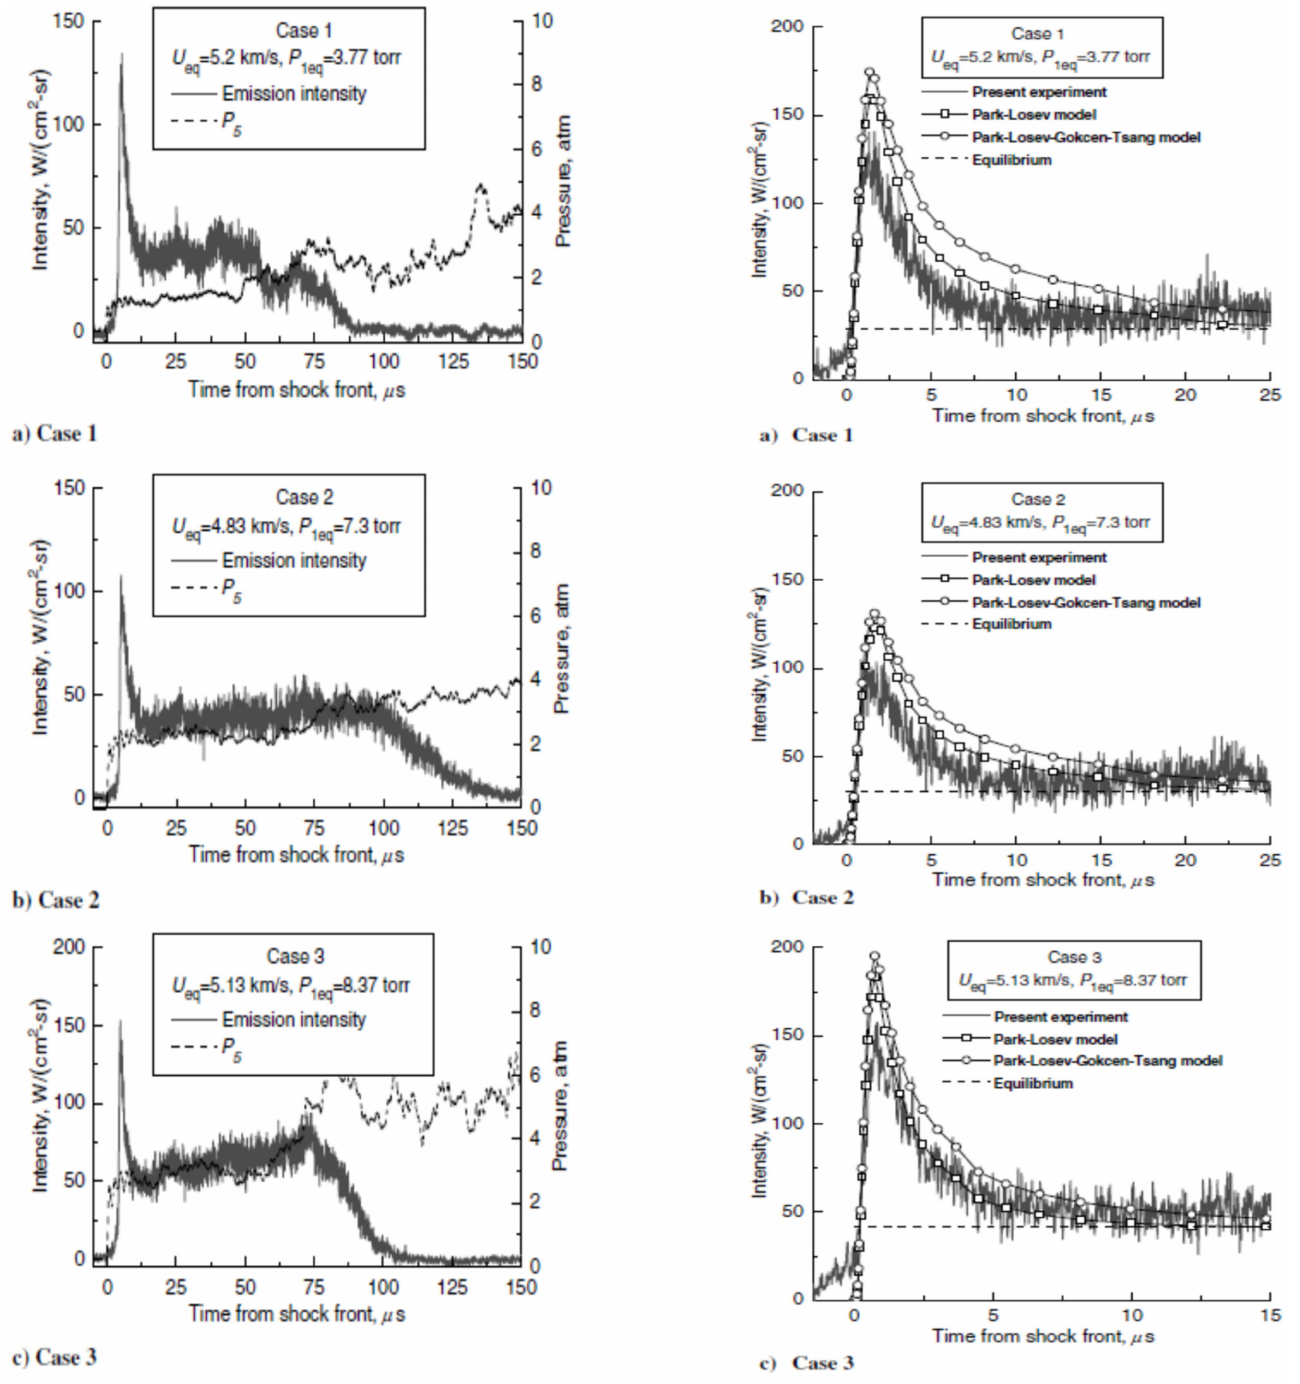
Figure 45. Left: Measured intensity and pressure behind the reflected shock. Right: Comparisons of numerical results with measurements (from